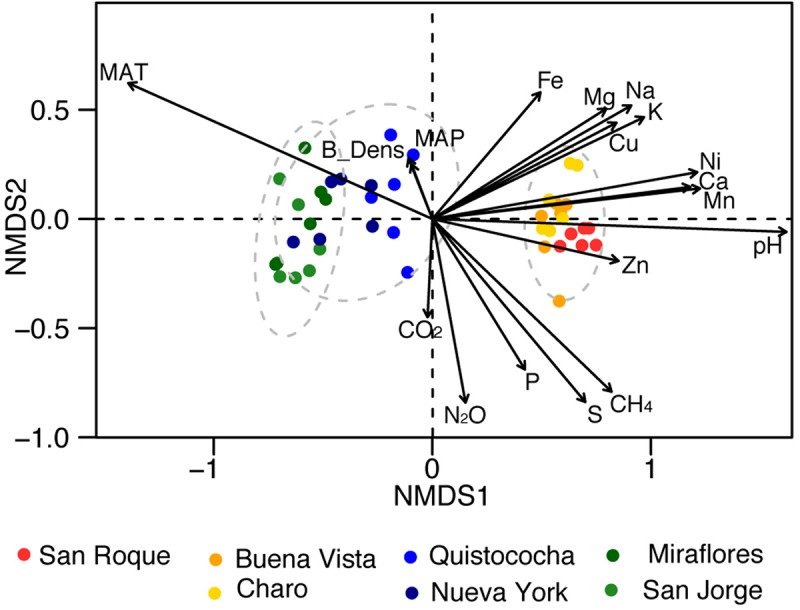
Non-metric multidimensional scaling (NMDS) of microbial community composition of the Pastaza-Marañón Basin peat soils (nodes), and climatological [MAT = mean annual temperature (°C) and MAP = mean annual precipitation (mm)], soil geochemical properties (B_Dens = bulk density, pH, Na, Mg, P, S, K, Ca, Mn, Fe, Ni, Cu, and Zn in units as per Table 1) and gas fluxes (CO2, CH4, and N2O in units as per Figure 1) as loadings. The dotted circles represent 95% confidence intervals of minerotrophic, mixed, and ombrotrophic communities.